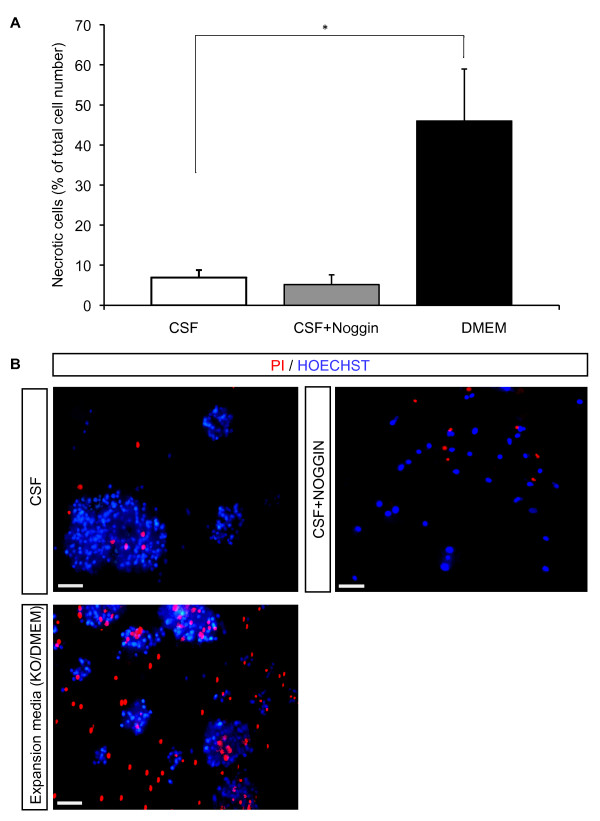
Survival rate of human adult NSCs during expansion. A, The percentage of necrotic NSCs expanded in culture medium supplemented with EGF and FGF-2 in comparison to CSF with or without 150 ng/ml Noggin was determined 72 hours after starting the expansion process. Values represent the mean ± S.E.M from at least three independent experiments. * indicates P < 0.05 and ** P < 0.01 compared to each corresponding value in CSF. B, Representative microphotographs demonstrating the influence of CSF on survival rate of NSCs. For immunostainings, dead cells were stained with propidiumiodid. Nuclei were counterstained with Hoechst 33342. The upper panel shows NSCs expanded in CSF (left photograph) and CSF+Noggin (right photograph), the lower panel shows NSCs expanded in expansion media supplemented with EGF and FGF. Scale bar = 50 μm